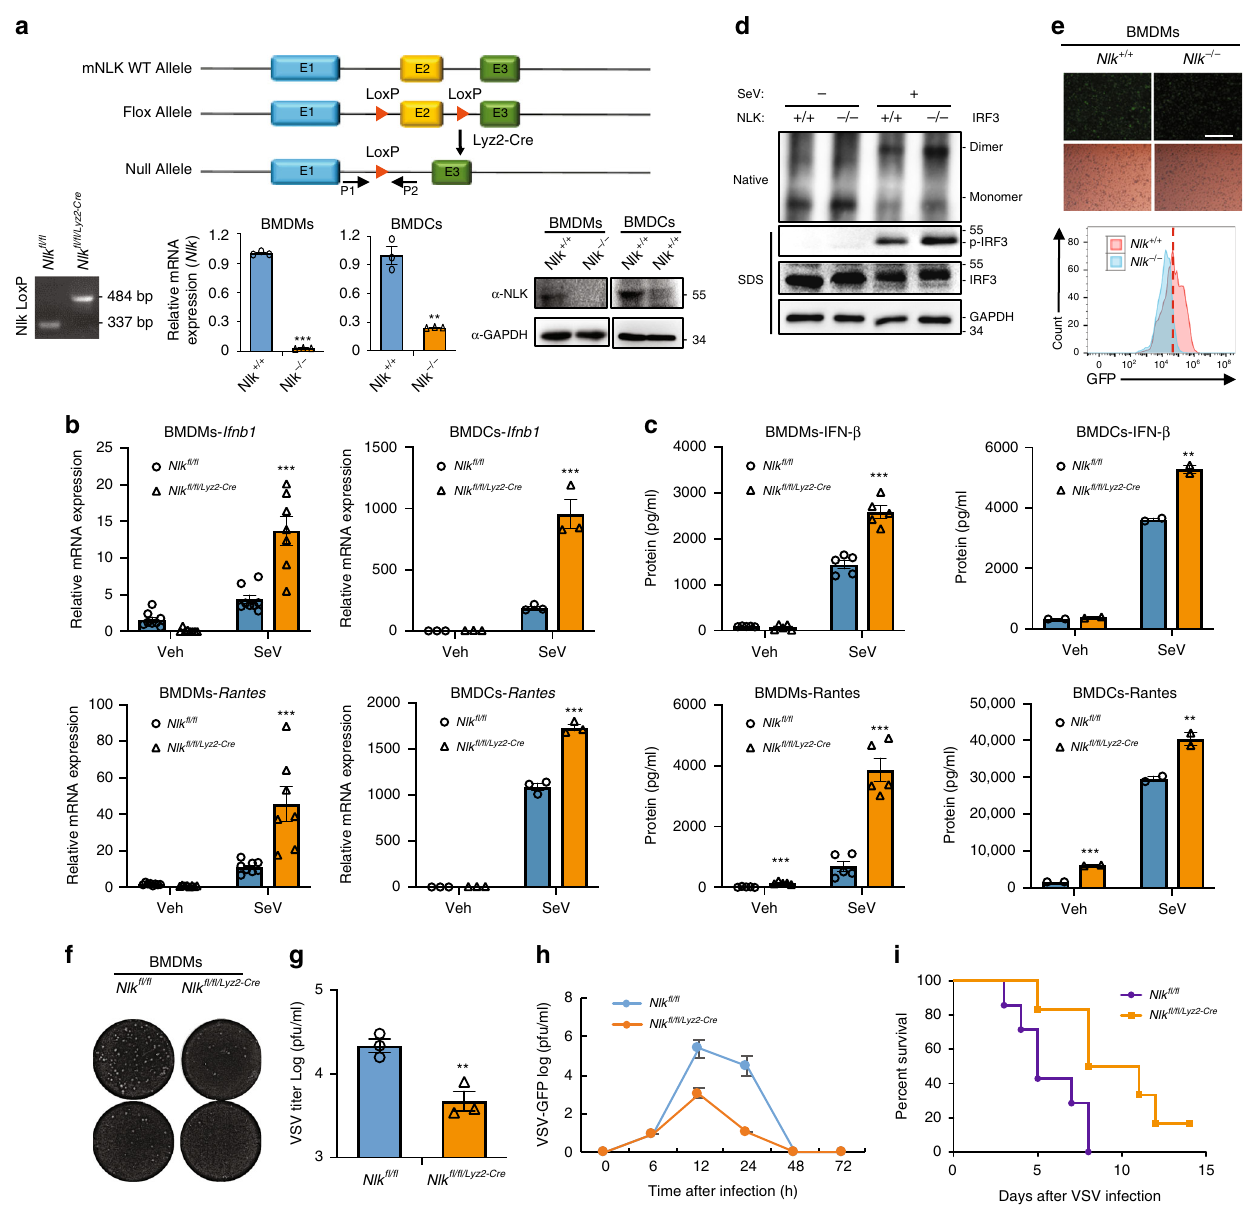
Fig. 2 NLK de fi ciency enhances the SeV-induced antiviral response in mice. a Generation and identi fi cation of mice with a conditional myeloid deletion of Nlk fl / fl /Lyz2-Cre . Top panel, targeting strategy for the deletion of exon 3 of NLK through homologous recombination. Bottom panel, identi fi cation of NLK deletion at the genome, mRNA and protein levels. b , c NLK de fi ciency potentiates SeV-induced Ifnb1 and Rantes gene and protein expression in BMDMs and BMDCs. NLK + / + and NLK − / − BMDMs as well as BMDCs were infected with SeV before performing real-time PCR experiments or ELISA ( n = 7 or 3 for b and n = 5 or 2 for c ). d NLK deletion facilitates SeV-induced IRF3 dimerization and phosphorylation in BMDMs. NLK + / + and NLK − / − BMDMs were infected with SeV or left untreated for 6 h. The cell lysates were then separated via native (top) or SDS (bottom three panels)-PAGE and immunoblotted with the indicated antibodies. e NLK de fi ciency in BMDMs inhibits VSV-GFP infection. NLK + / + and NLK − / − cells were infected with VSV-GFP at an MOI of 4 for 12 h before phase-contrast and fl uorescence microscopy and fl ow cytometry analysis. Scale bar is 500 µ m. f , g NLK de fi ciency in BMDMs potentiates the antiviral response. NLK + / + and NLK − / − cells were infected with VSV at an MOI of 4, and the culture supernatants were diluted and added to Vero cells. After fi xation, cells not killed by the virus were stained with crystal violet, and the viral titer was determined ( n = 3). h Wild-type and Nlk fl / fl /Lyz2-Cre mice were infected with VSV-GFP (2 × 10 7 pfu) via tail vein injection. Their sera were collected at different time points and subjected to plaque assays ( n = 6). i Survival assays of wild-type and Nlk fl / fl /Lyz2-Cre mice (6 – 7 weeks). Wild-type and Nlk fl / fl /Lyz2-Cre mice were infected with wild-type VSV (2 × 10 7 pfu) via tail vein injection. The survival of the mice was monitored for 2 weeks ( n = 6). Veh: vehicle medium. Data are representative of three b – i independent experiments. Data are presented as the mean ± SEM. Statistical signi fi cance was analyzed by ANOVA or Student ’ s t -test (* p < 0.05, ** p < 0.01, *** p < 0.001). Source data ( a – d , g – i ) are provided as a Source Data fi